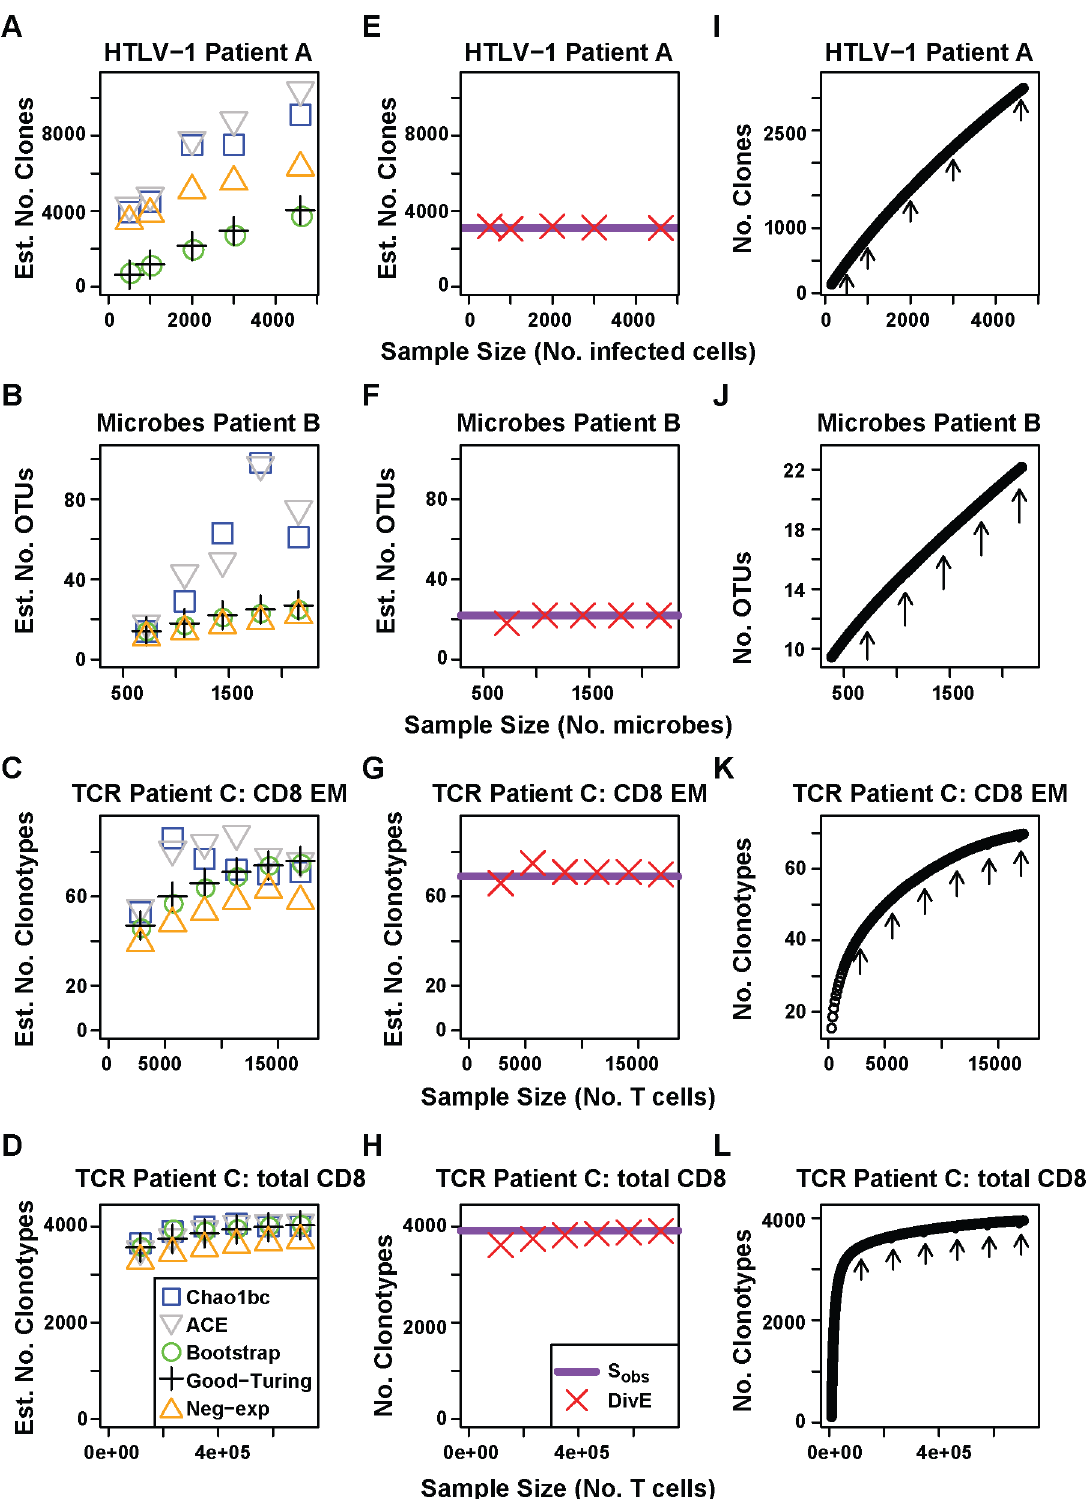
Figure 3. Comparison of species richness estimators. A–D The Chao1bc (blue), ACE (grey), Bootstrap (green), Good-Turing (black), and negative-exponential estimators (orange) are applied to in silico random subsamples of observed data. Examples for HTLV-1, microbial, and TCR data are shown. Estimates systematically increase with sample size in datasets where rarefaction curves do not plateau (e.g. in I , J , K ). Where rarefaction curves do plateau (e.g. in L ), estimates are consistent. E–H DivE (red) is applied to same subsamples as the other estimators. Performance of DivE was evaluated by comparing the error of estimates ( Sˆ obs ), to the (known) number of species S obs in the full observed data (purple line), i.e. error =| S obs - Sˆ obs | / S obs . In all datasets, DivE accurately estimates the species richness of the full observed data from subsamples of that data. I–L Corresponding HTLV-1, microbial and TCR rarefaction curves: arrows denote the size of the subsample to which each estimator was applied.